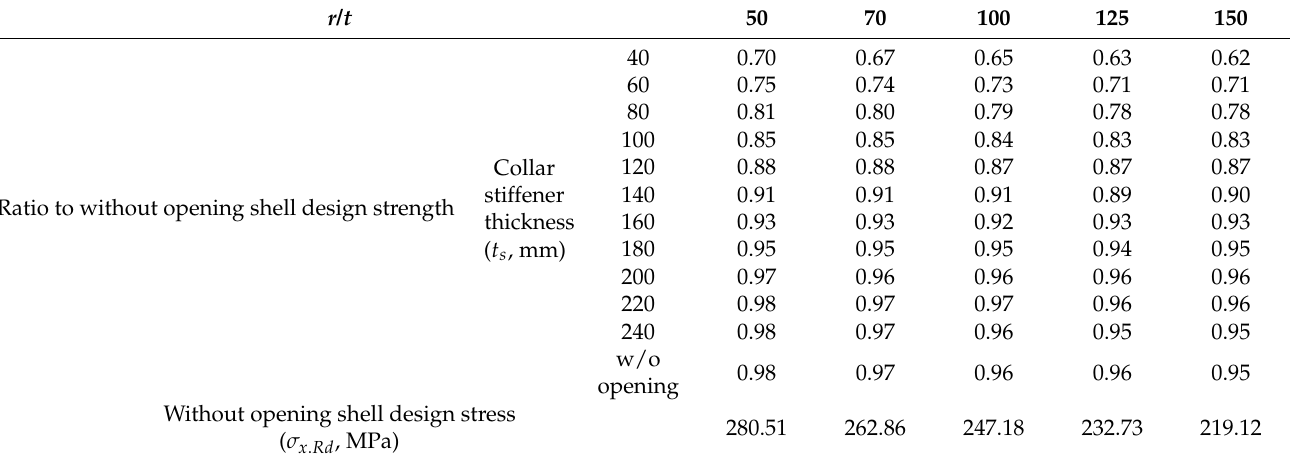
Table 8. Comparison of geometric and material nonlinear analysis results by